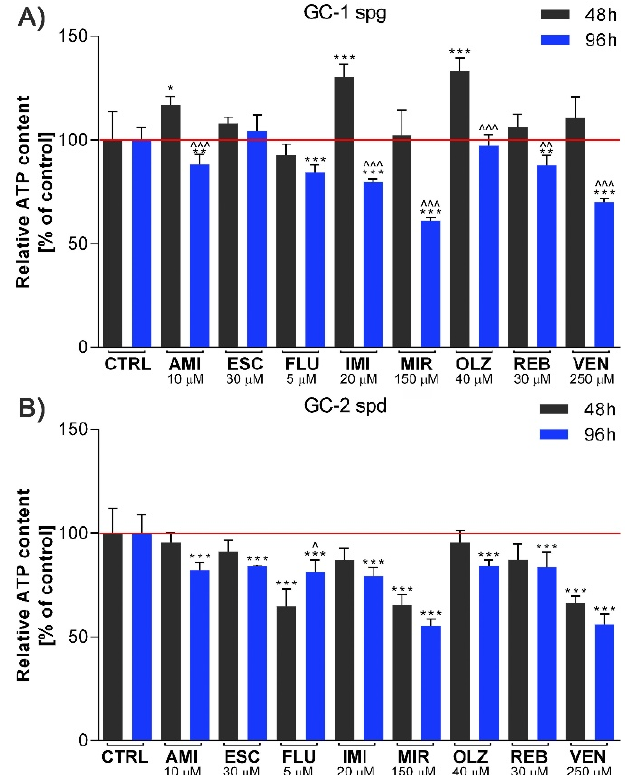
Figure 1. Antidepressants interfere with spermatogenic cells energy production. GC-1 spg ( A ) and GC-2 spd ( B ) cells were exposed to antidepressants for 48 or 96 h. The ATP production was then measured. Statistical differences were determined using one-way analysis of variance (ANOVA) with Dunnett’s post-hoc test; p values < 0.05 were considered statistically significant. Asterisks (*) indicate the comparison between control and antidepressants-treated cells, whereas carets (^) indicate the comparison between the same drugs in different periods (48 vs. 96). Bars indicate mean ± SD, n = 3, ***/^^^ p < 0.001, **/^^ p < 0.01, */^ p < 0.05, no indication–no statistical significance.